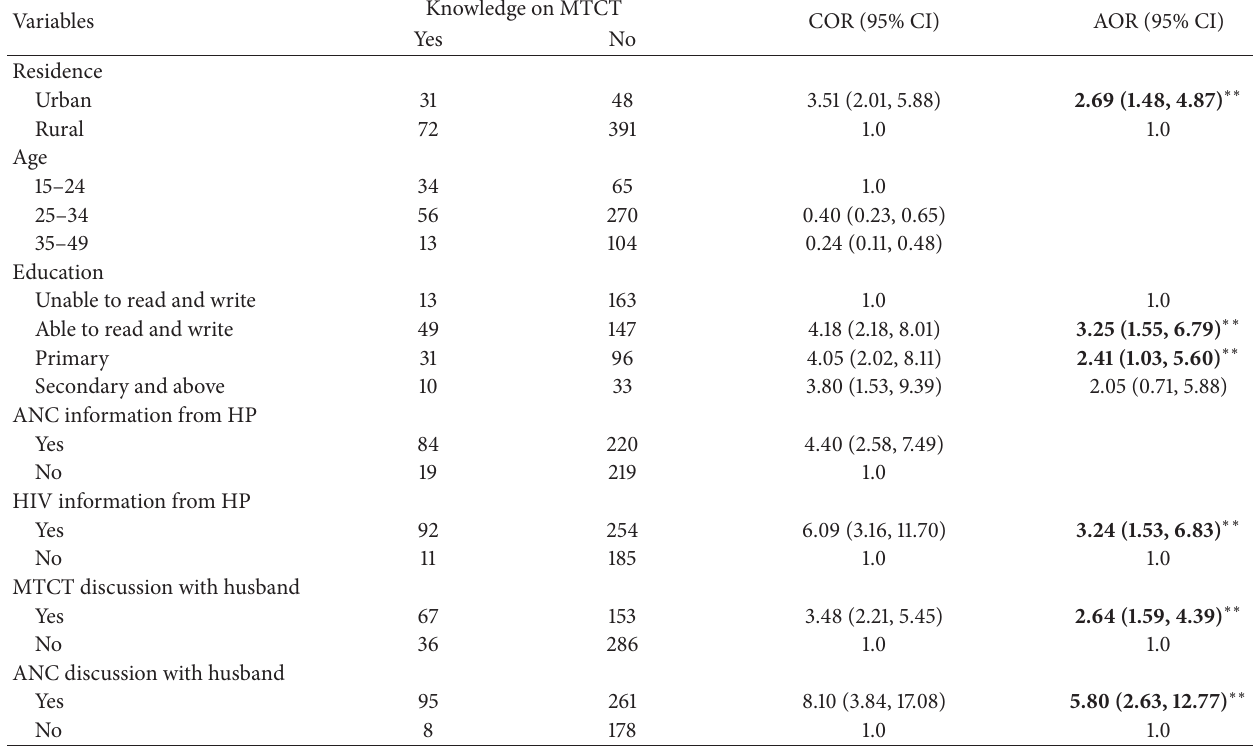
Table 3: Crude and adjusted odds ratios (OR) and 95% confidence intervals (CI) of factors associated with knowledge of mothers on MTCT of HIV among pregnant women, Meket district, 2014 ( 𝑛 = 542